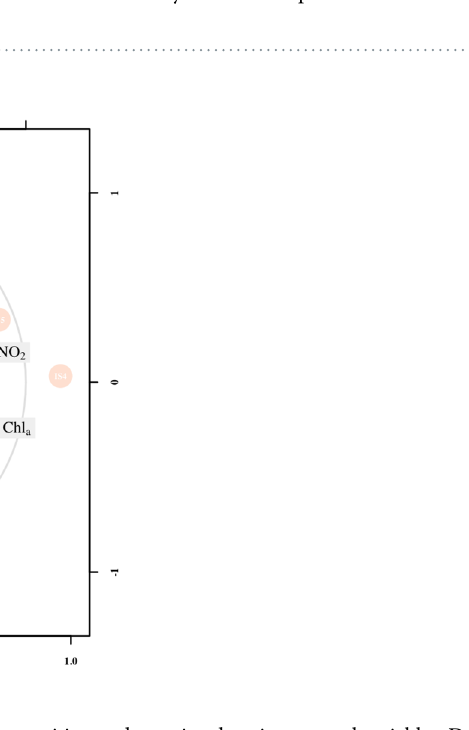
Figure 3. dbRDA based on coral reef survey benthic composition and associated environmental variables. Depth; Distance, distance to the main shoreline; SiO 2 , silicates; PO 4 , phosphates; NO 2 , nitrites; Chla, chlorophyll a .